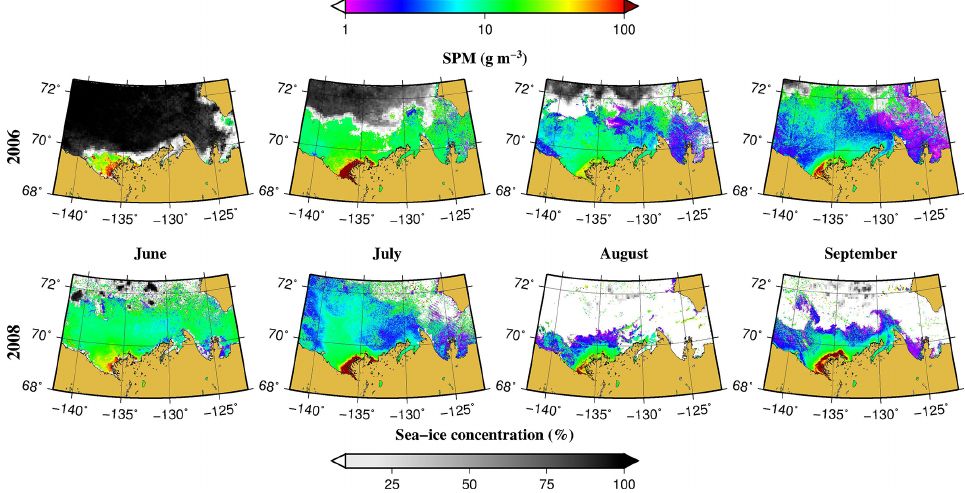
Figure 7. Same as Fig. 6 but for 2006 and